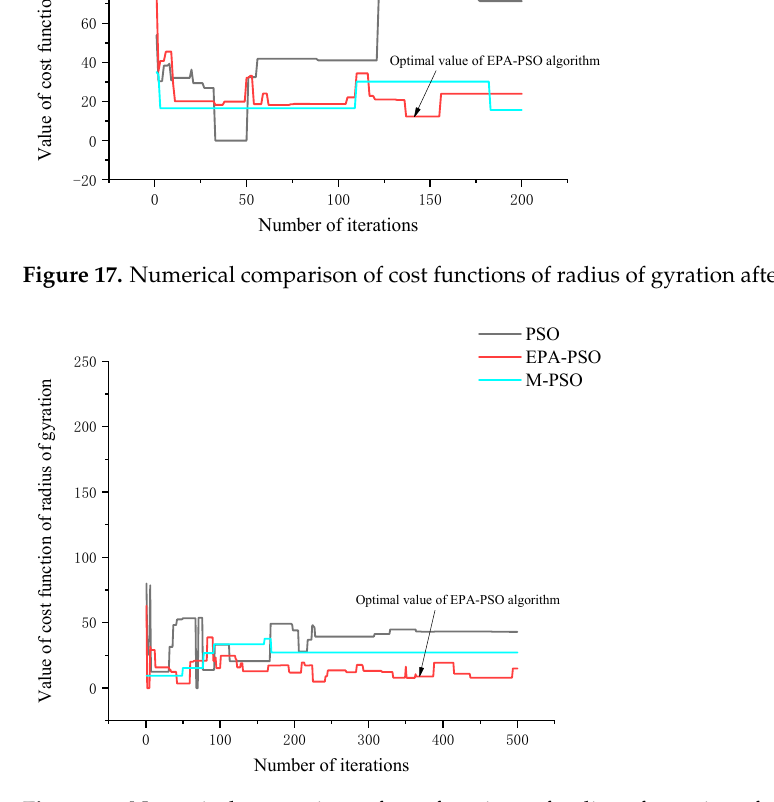
Figure 18. Numerical comparison of cost functions of radius of gyration after 500 iterations.